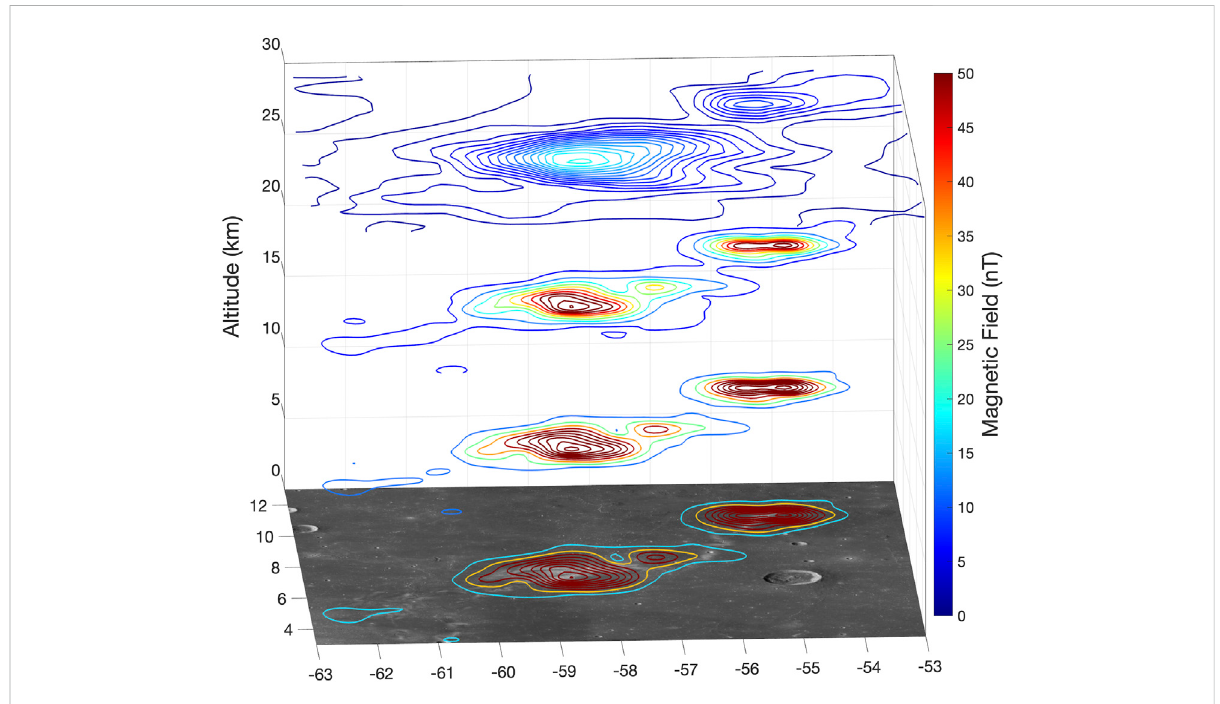
FIGURE 6 TheReinerGammamagneticanomalytotal fi eldinthelunarwakeisrepresentedbycontourslicesat1 m,10,and30 kmaltitude,wherethelast slice is at LP average orbital height.